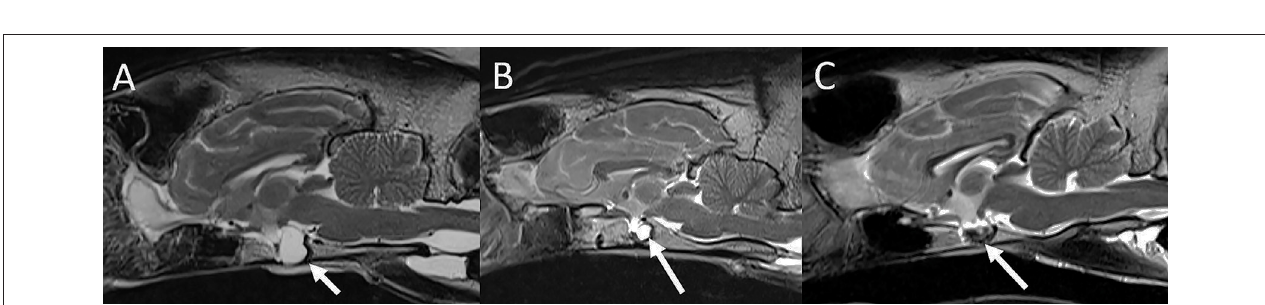
FIGURE 7 | Pituitary abnormalities. Sagittal T2-W images of the brain showing (A) a large cyst-like lesion (cystadenoma) associated with the pituitary fossa in a cougar, (B) an empty sella in a tiger, and (C) a mildly nodular and heterogeneous pituitary gland (mild chronic multifocal nodular pituitary hyperplasia) in a leopard